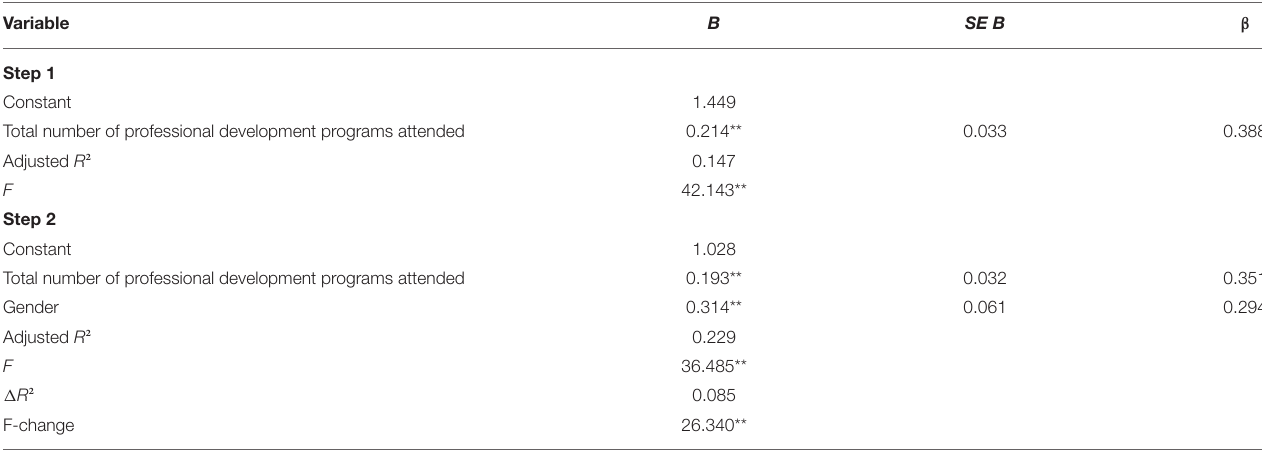
TABLE 2 | Mean Scores (M) and Standard Deviation (SD) of knowledge and use of evidence-based practices. Evidence-based practices